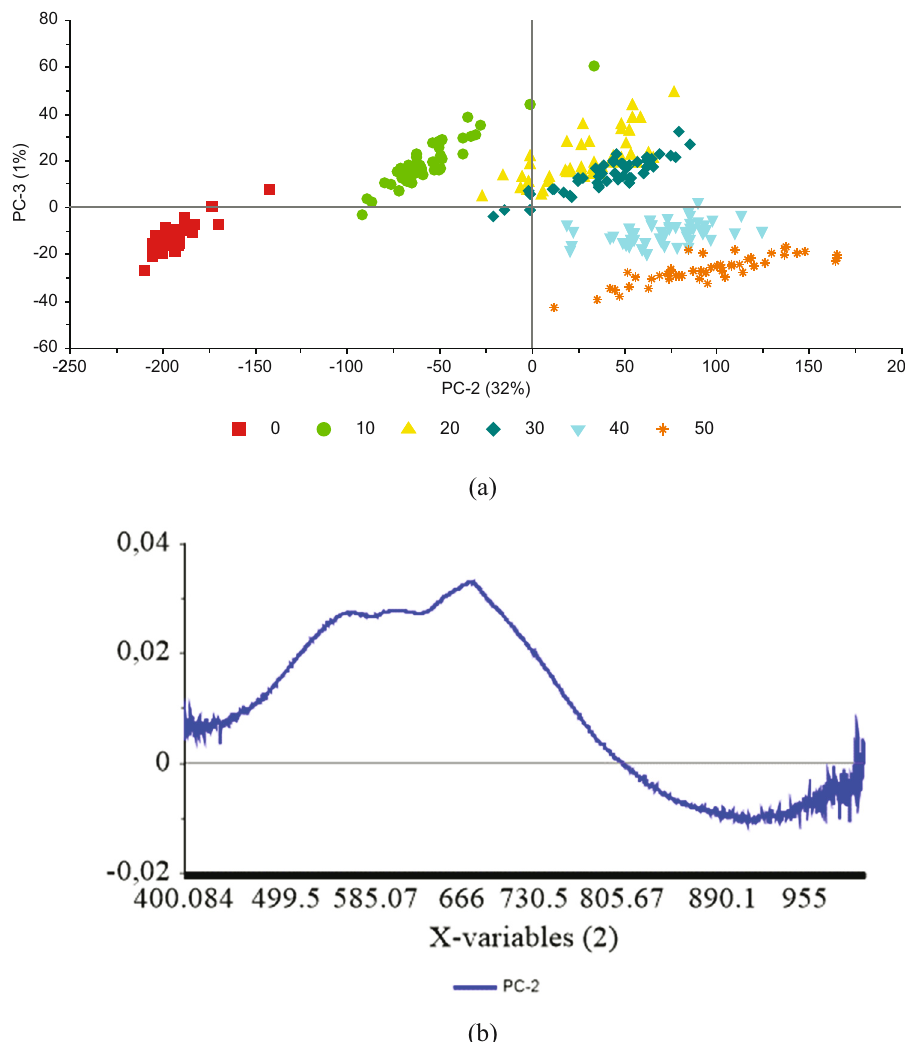
Figure 5: PCA of pure ( 0% adulterant ) and SPI - adulterated butter fl y - pea extract powder at 10, 20, 30, 40, and 50% concentrations: ( a ) score plot; ( b ) loading plot using the original